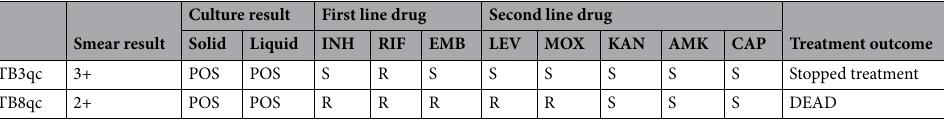
Table 3. Laboratory results, phenotypic drug sensitivity test and treatment outcome from the two sequenced samples. POS positive, INH isoniazid, RIF rifampicin, EMB ethambutol, LEV levofloxacin, MOX moxifloxacin, KAN kanamycin, AMK amikacin, CAP